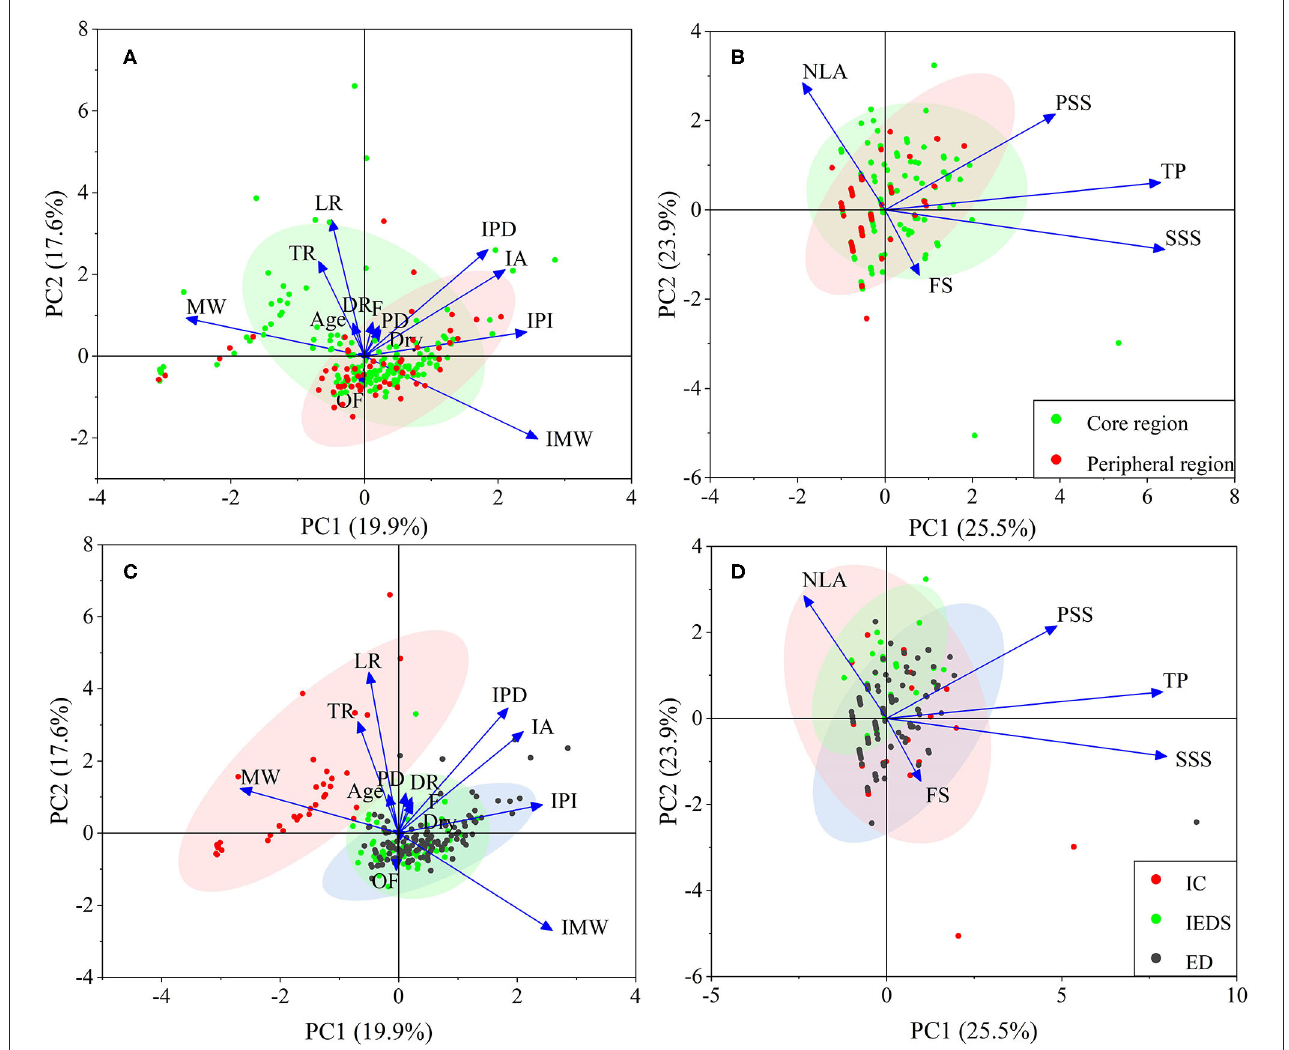
FIGURE9 PCA plots of farm household livelihood vulnerability under two classifications: (A, B) sensitivity and response for spatial classification, respectively; (C, D) sensitivity and responsiveness for the three farm household types, respectively.